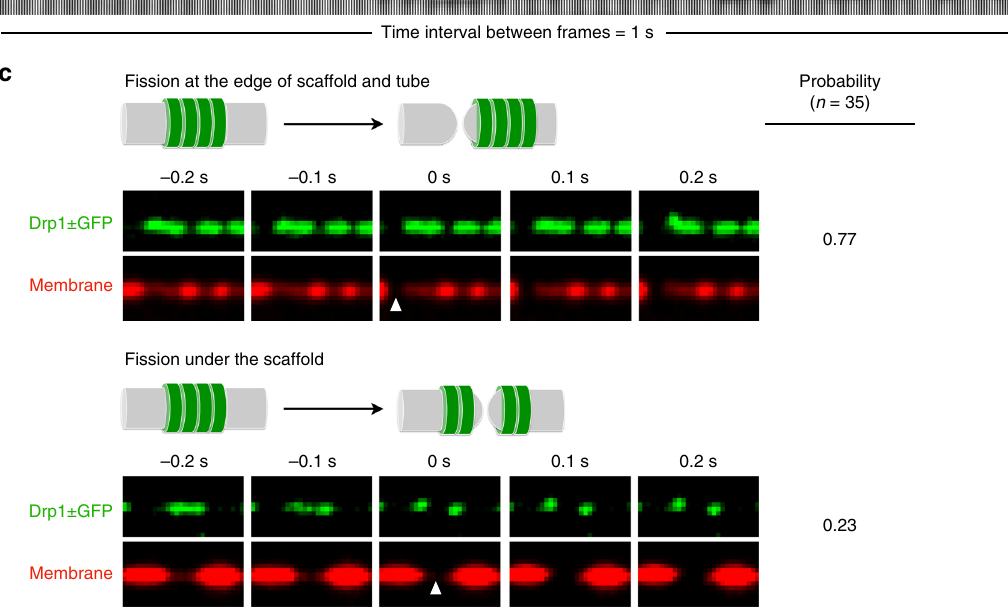
Fig. 7 Mechanism of Drp1-catalyzed fi ssion. a Frames from a representative time-lapse movie showing the effect of GTP addition to preassembled Drp1 scaffolds. Also shown are line pro fi les of tube fl uorescence at the indicated time points. White arrowheads mark constrictions formed by Drp1 scaffolds, red arrowhead marks the site of fi ssion. b Montage of tube images from a representative experiment shown decline and recovery of tube fl uorescence at sites marked by black arrowheads. c Frames from a time-lapse movie showing the distribution of Drp1 ± GFP (green) on the tube (red) under conditions where the scaffold remains intact (top) and when it undergoes splitting (bottom) after fi ssion. White arrowhead marks the site of tube fi ssion. Also shown is the probability of these two types of fi ssion